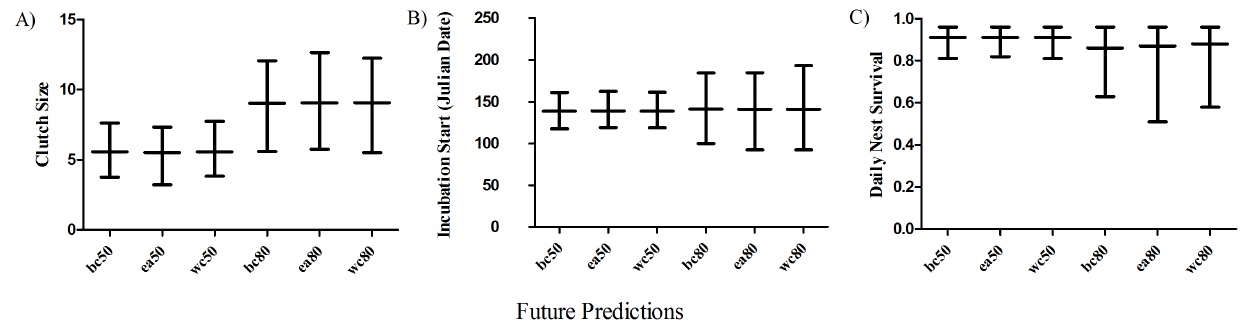
Figure 2. Future predicted values for clutch size, incubation start date, and nest survival. Mean and lower and upper 95% confidence limits of future lesser prairie-chicken A) clutch size, B) incubation start date, and C) nest survival from 1,000 simulations. Each graph presents results from six scenarios: wc50 - worst case scenario, 2050; bc50 - best case scenario, 2050; ea50 - ensemble average scenario, 2050; wc80 - worst case scenario, 2080; bc80 - best case scenario, 2080; ea80 - ensemble average scenario, 2080. doi:10.1371/journal.pone.0068225.g002 variable under the 40-year and 70-year scenarios (Tables 2, 3), average incubation initiation is not predicted to change in either 2050 or 2080 (Figure 2).